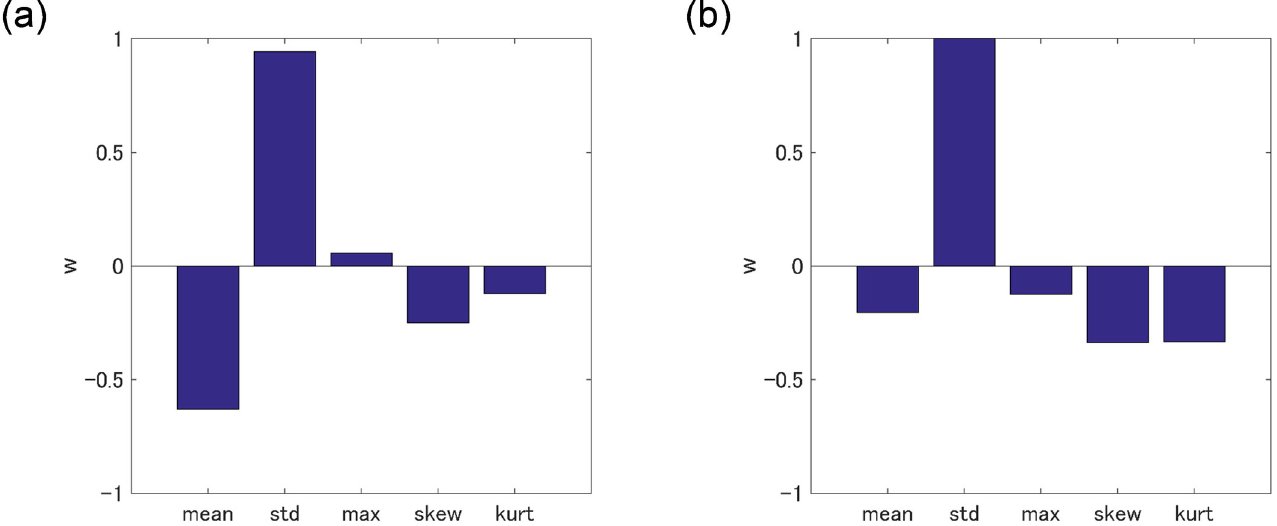
Fig 8. Weight vectors ( w ) of SMV classifiers visualized in five statistical parameters. (a) Weight vector for statistical parameters of OPL/PL and (b) weight vector for statistical parameters of OPL/D.